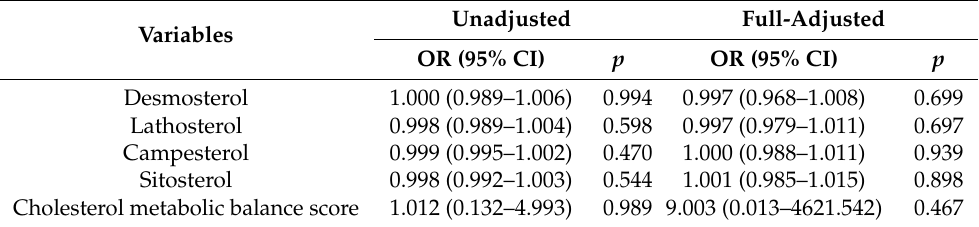
Table 4. Logistic regression for macrovascular events prediction using cholesterol homeostasis